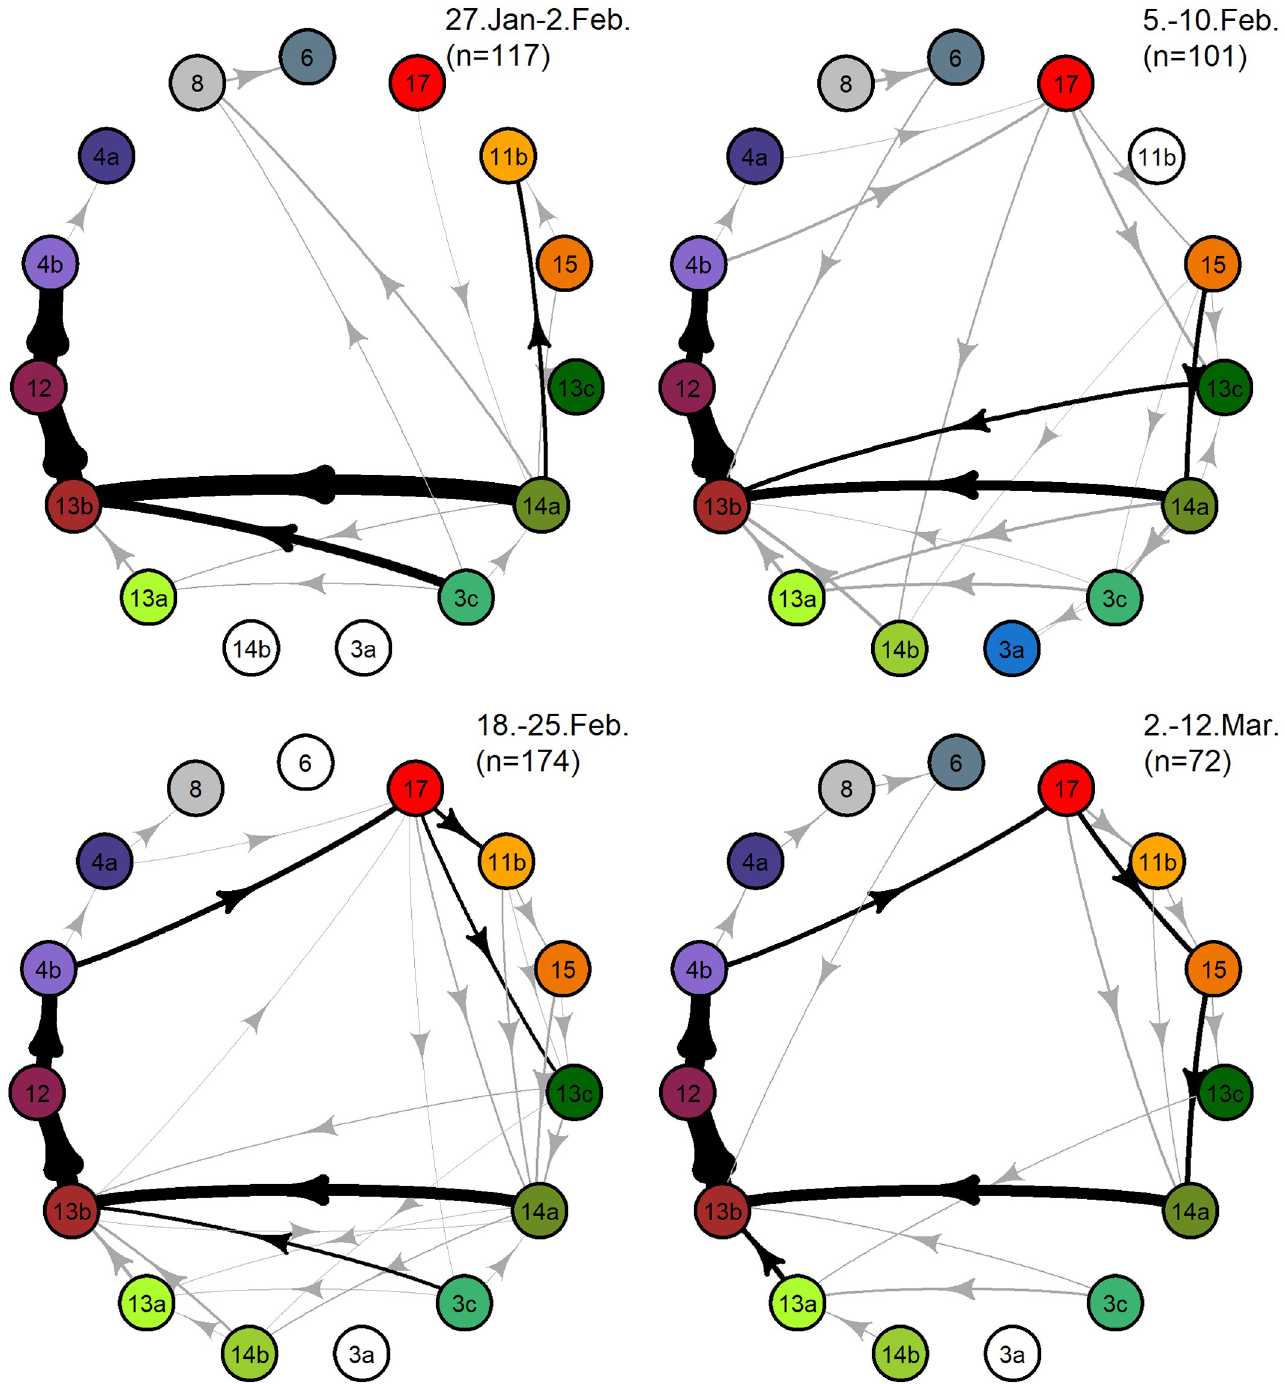
Fig 7. A diagram of phrase transitions. A diagram based on Markov transition matrix of song sequences during each period. Each circle in the The table summarizes the most likely sequences per period according to the diagram represents a phrase type. The colored circles are phrases which were Markov matrices. The set median sequences from each period are shown observed during each particular period while the white phrases were not observed during that particular period, only in other periods. The data points (n) represent the number of analyzed transitions observed during each period. Black lines represent transitions occurring a minimum of 5% of the time while gray lines represent transitions occurring less than 5% of the time. Single transition events are represented with thin light gray lines. The line thickness indicates the prevalence and frequency of the transitions observed, i.e. thicker lines indicate more common transitions.